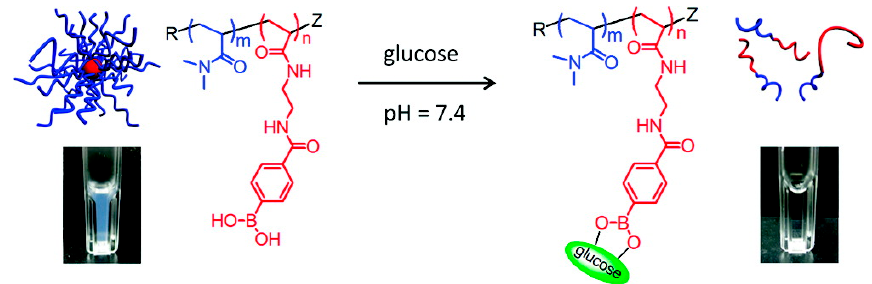
Figure 4. Structure and schematic representation of the micellar association/dissociation under the influence of glucose at physiological pH for P(DMA-block-DDOPBA) [21]. Copyright 2012 American Chemical Society.